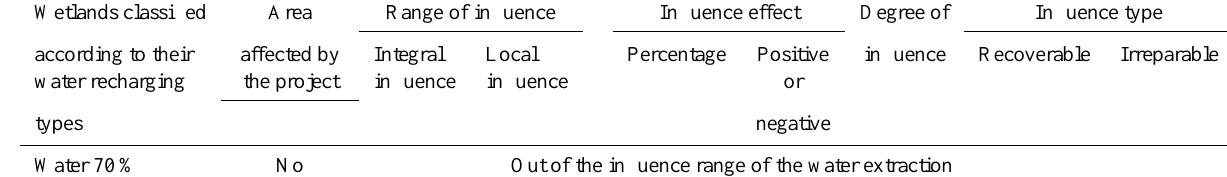
Table 5. Integrated evaluation of the influence of the western route project on marsh wetlands. Wetlands classified